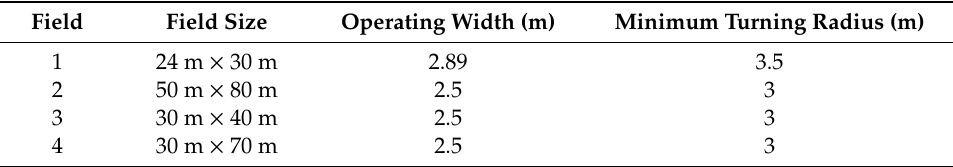
Table 2. Input data related to the fields and applied machine.